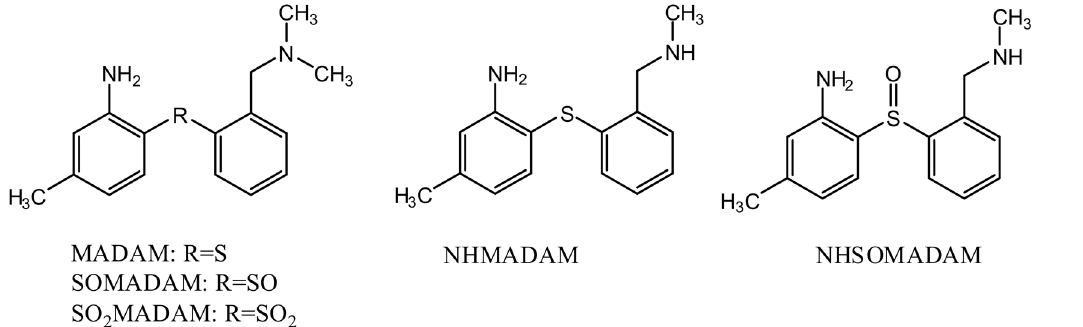
Fig 2. Chemical structures of MADAM, SOMADAM, SO 2 MADAM, NHMADAM and